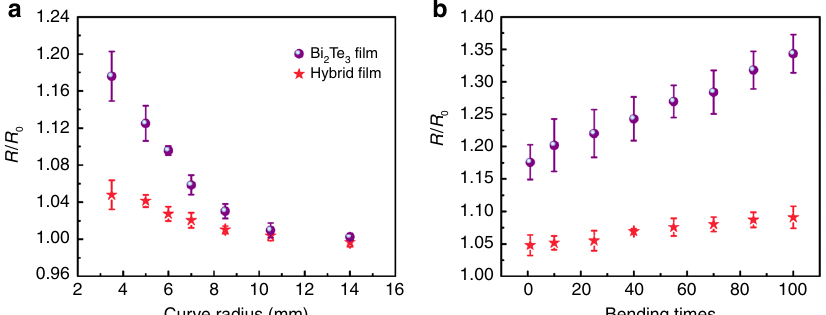
Fig. 5 Mechanical fl exibility. Comparison of the fl exibility between PEDOT/Bi 2 Te 3 (100) hybrid fi lms with ~31 vol% Bi 2 Te 3 nanoparticle fraction (red pentacle) and Bi 2 Te 3 fi lms (purple circle). a The resistance R of the fi lm as a function of curve radius r , where R 0 is the resistance before bending. b The resistance of the fi lms as a function of bending times with a curve radius of 3.5 mm. Each point shows the standard deviations from three independent measurements. All fi lms were prepared on fl exible polyimide interfacial surface-to-volume ratio showed the best mechanical fl exibility. In addition to the bending effect on the electrical conductivity, the bending radius effect on the Seebeck coef fi cient was also examined as shown in Supplementary Fig. 19. These results demonstrate the fl exible hybrid thermoelectric fi lms are possible to be tailored as new types of devices outside of the domain of conventional rigid inorganic thermoelectric materials.